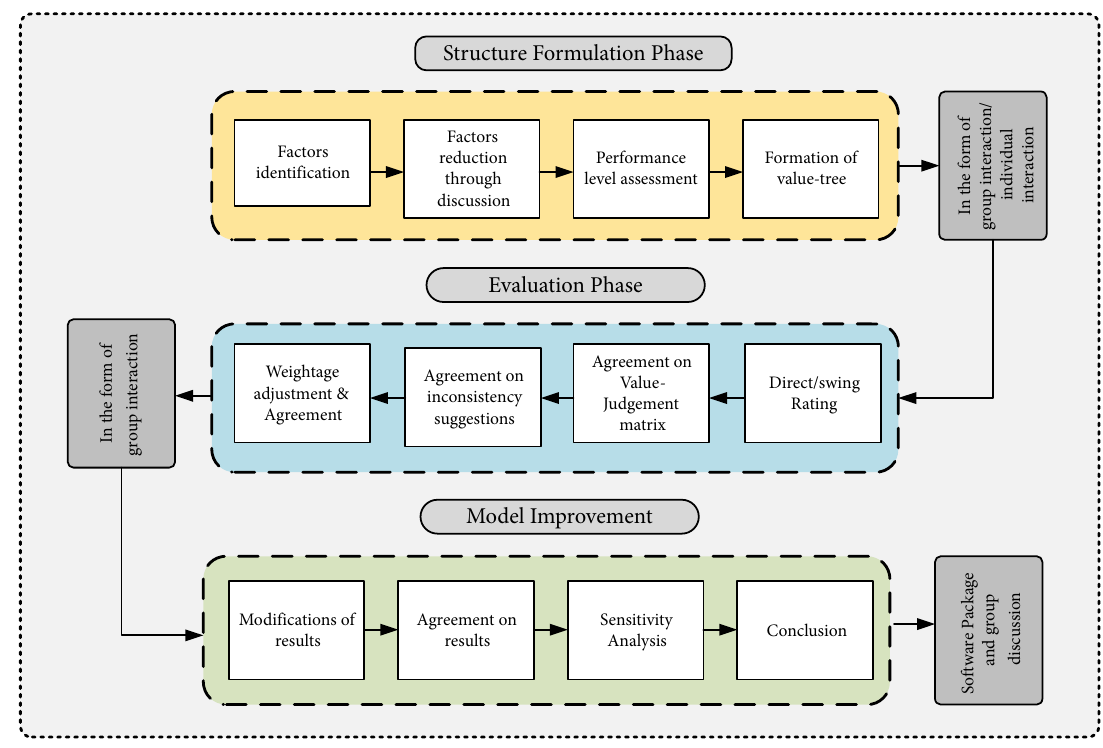
Figure 2. Embedded group decision-making process in classical